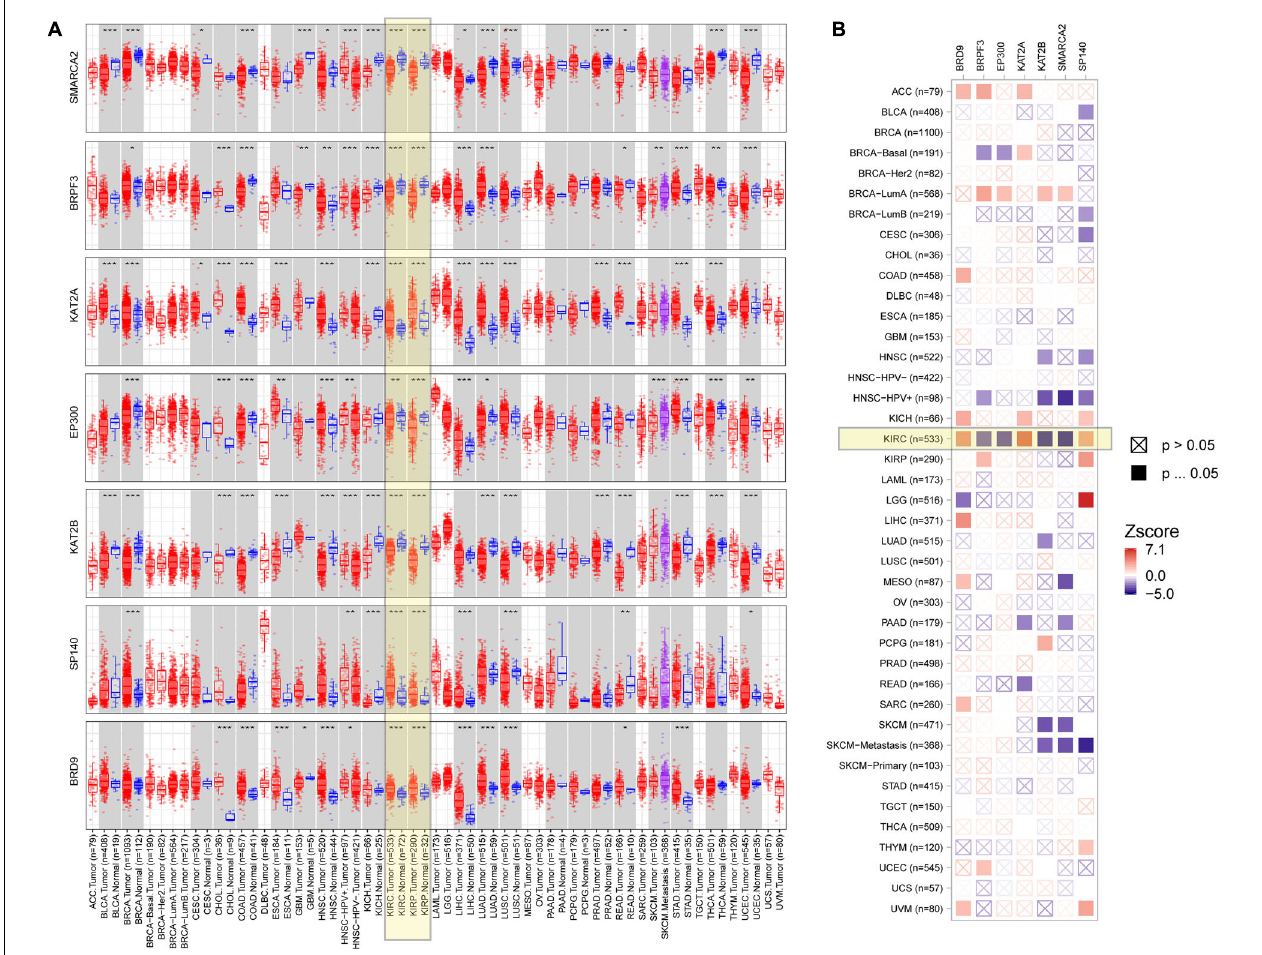
FIGURE 8 | Expression level and clinical relevance of the signature genes in different tumors. (A) The expression status of the signature genes in different cancers or specific cancer subtypes (* P < 0.05; ** P < 0.01; *** P < 0.001). (B) Heatmap table of the normalized coefficients of the signature gene expression in the Cox proportional hazard